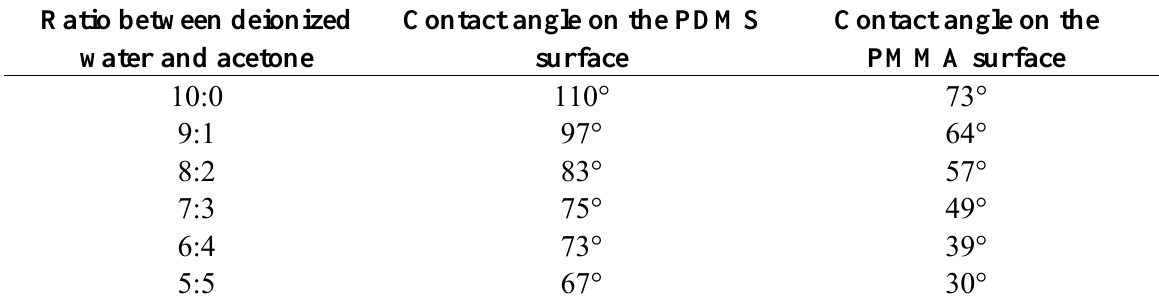
Table 1. The contact angle with respect to the ratio between deionized water and acetone. Ratio between deionized